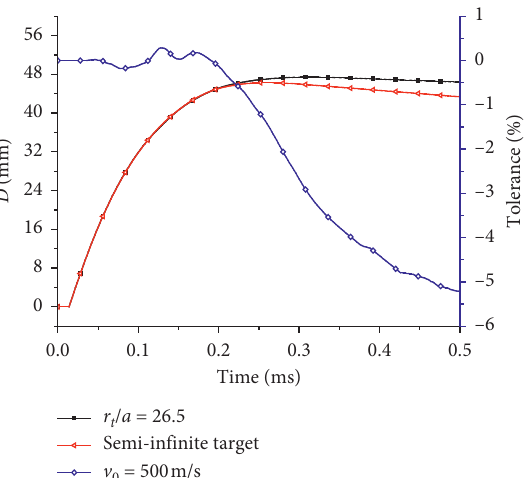
Figure 21: Deviation comparison of the penetration depth for the free boundary ( r t / a � 26.5) and the nonreflecting boundary ( v � 500m/s).